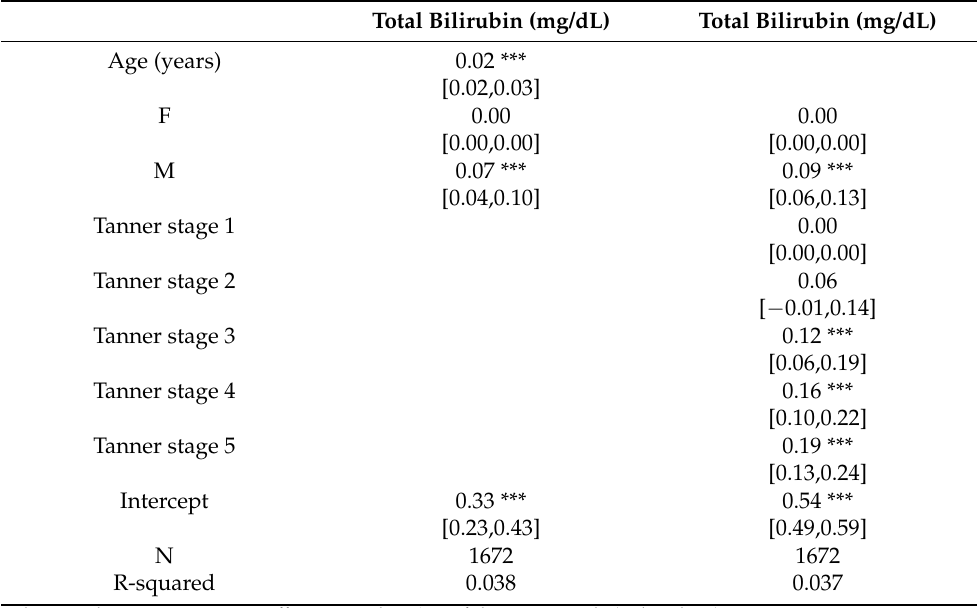
Table 2. Multivariable linear regression models evaluating the association between serum total bilirubin and age and pubertal status.